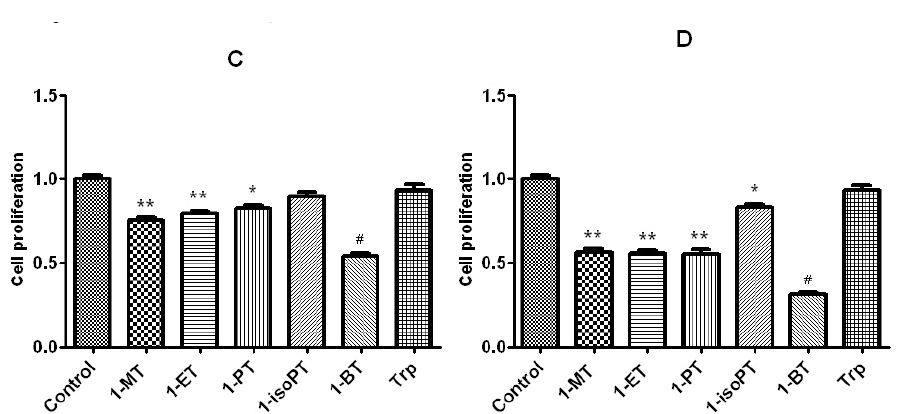
Figure 3. The effect of 1 mmol/L of target compounds on SGC7901and Hela cells growth.